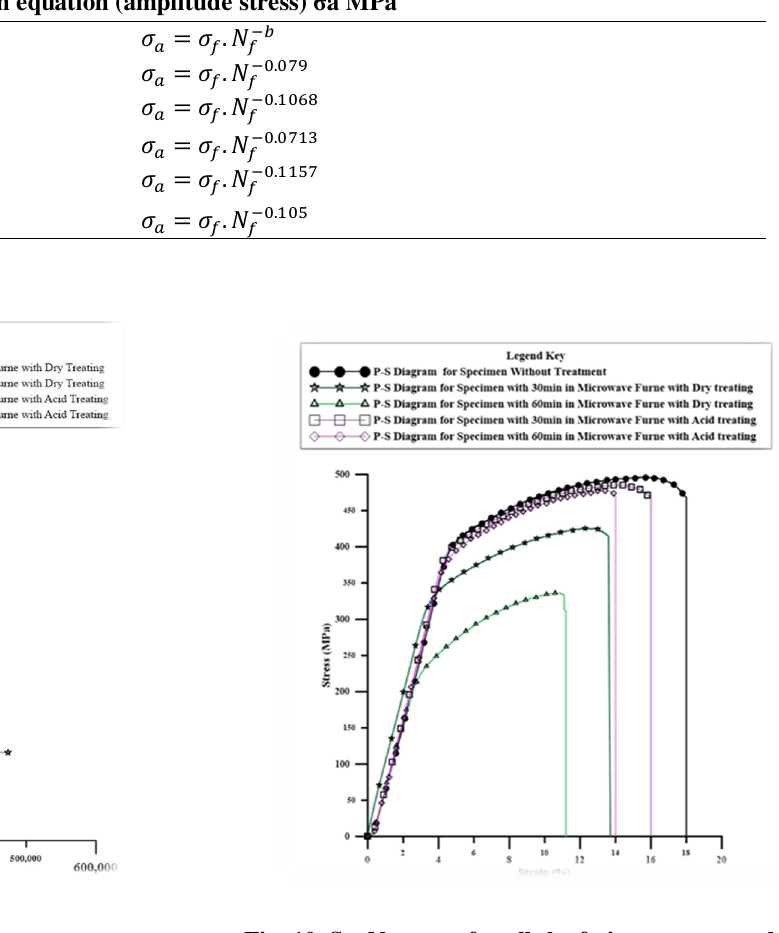
Fig. 9. Stress-Strain chart for tensile test. Fig. 10. S – N curves for all the fatigue tests